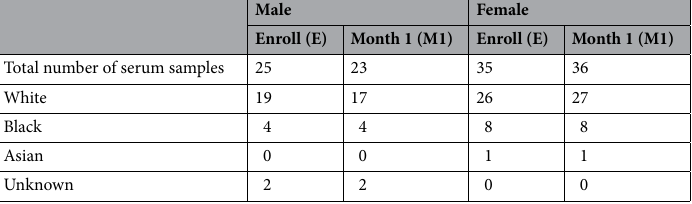
Table 2. One-month longitudinal serum samples from symptomatic COVID-19 patients. White, Caucasian/ European; Black, African American/African.